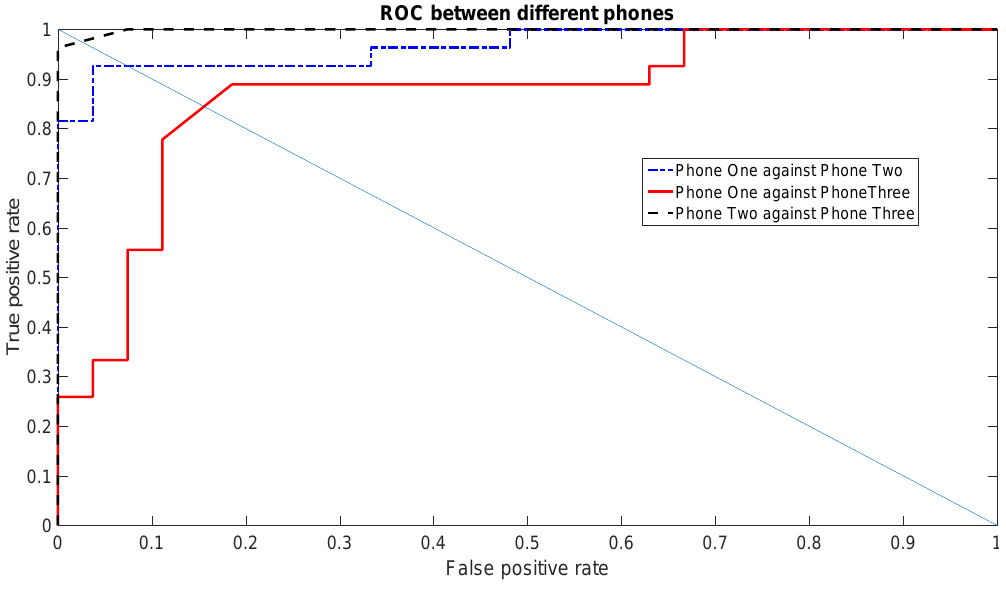
Figure 13. ROCs among different phones using the first scenario for Gyroscope Y for a single day’s data in the second set of